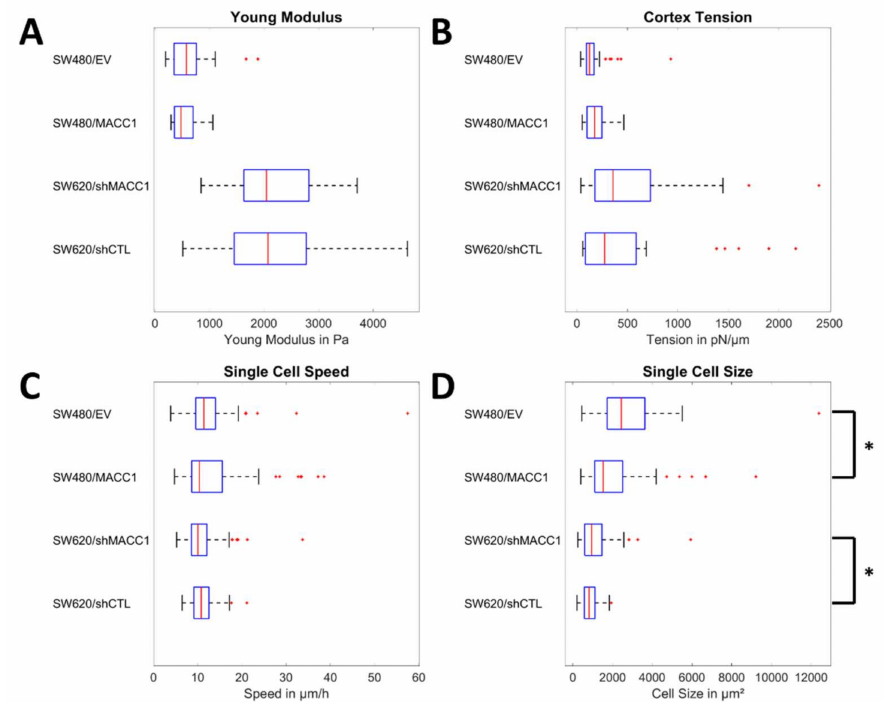
Figure 1. Single cell properties of high- and low-MACC1-expressing colon carcinoma cells. ( A , B ) depict the results of the biomechanical measurements for the Young ´ s modulus and the cortex tension. ( C , D ) show the results of live cell imaging of single cells for the mean speed and the contact area with the substrate. Sample sizes: ( A ) n SW480/EV = 35; n SW480/MACC1 = 33; n SW620/shMACC1 = 40; n SW620/shCTL = 40. ( B ) n SW480/EV = 33; n SW480/MACC1 = 31; n SW620/shMACC1 = 25; n SW620/shCTL = 26. ( C , D ) n SW480/EV = 66; n SW480/MACC1 = 98; n SW620/shMACC1 = 102; n SW620/shCTL = 111. Asterisk de- picts statistically significant results with p < 0.05. Box plots show the median (red line), 25 and 75 percentile (box), non-outlier range (whiskers), and outliers (red